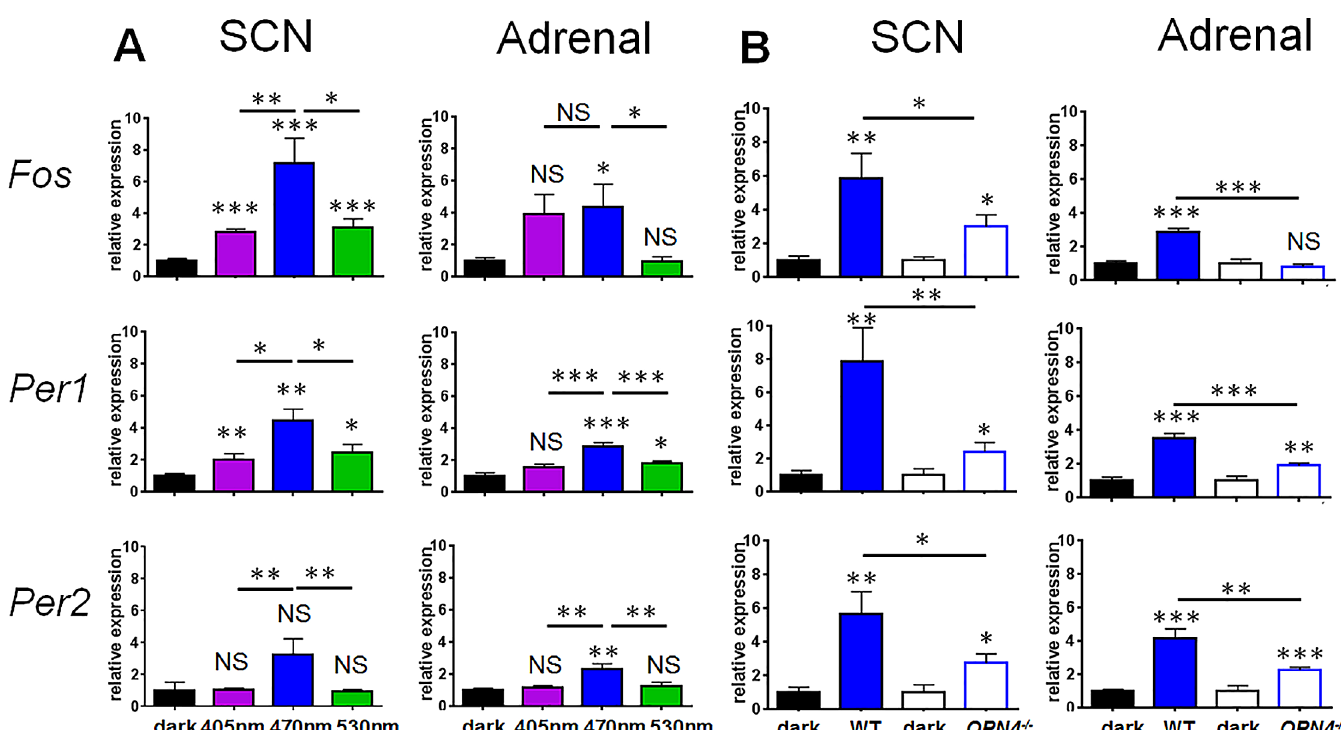
Fig 4. Wavelength-dependent effects on immediate early gene expression in the SCN and adrenal gland. ( A ) Relative mRNA expression of Fos , p (cid:1) 0.001), Per1 , and Per2 after 1 hr monochromatic light pulse in the SCN and adrenal gland. One-way ANOVA for wavelength, Fos (F (3.18) = 23.615 posthoc Tukey dark versus violet p (cid:1) 0.001, dark versus blue p (cid:1) 0.001, dark versus green p (cid:1) 0.001; Per1 (F (3.23) = 10.366, p (cid:1) 0.001) dark versus violet p = 0.006) dark versus violet p = 0.196, dark versus blue p = 0.036, dark versus blue p (cid:1) 0.001, dark versus green p = 0.007); Per2 (F (3.19) = 5.715 p (cid:1) 0.001, dark versus green p = 0.265). A significant effect of wavelength was observed in the SCN for all three genes (one-way ANOVA for wavelength, p = 0.004; Per1 F p = 0.021; Per2 F p = 0.004), with blue light showing significantly greater Fos , Per1 , and Per2 Fos F (2,14) = 8.603, (2,19) = 4.740, (2,14) = 8.565, expression in the SCN compared to either violet (posthoc Tukey Fos p = 0.006, Per1 p = 0.014, Per2 p = 0.008) or green light (posthoc Tukey Fos p = 0.012, Per1 p = 0.028, Per2 p = 0.008). In the adrenal gland, responses to blue light were significantly greater than either green or violet light. Both blue and green light induced Per1 expression (one-way ANOVA for wavelength, Per1 F (3,36) = 13.070, p < 0.001; posthoc Tukey dark versus violet p = 0.098, dark versus blue p < 0.001, dark versus green p = 0.023). Blue light produced significantly greater Per1 induction compared to either green or violet light (green versus blue p = 0.001, violet versus blue p < 0.001). Fos and Per2 expression were also induced by blue light but not violet or green light (one way ANOVA for wavelength Fos F (3.31) = 2.516 p = 0.076, dark versus blue p = 0.045; Per2 F (3.31) = 7.033 p = 0.001, dark versus blue p = 0.004). Neither violet nor green light produced a significant induction of Fos or Per2 expression ( Fos dark versus violet p = 0.063, dark versus green p = 0.979, Per2 dark versus violet p = 0.961, dark versus green p = 0.998). ( B ) Responses to blue light were subsequently studied in Opn4 -/- mice (open bars) compared with wildtype mice (solid bars). Opn4 -/- mice showed light induced gene expression for all three genes in the SCN, but responses were significantly attenuated in comparison to wildtype animals (unpaired t test wildtype versus Opn4 -/- Fos p = 0.029, Per1 p = 0.007, Per2 p = 0.029). In the adrenal gland Per1 and Per2 (but not Fos ) were induced in response to light. All three genes showed attenuated responses in comparison to wildtype mice (unpaired t test wildtype versus Opn4 -/- Fos p < 0.001, Per1 p < 0.001, Per2 p = 0.002). The geometric mean of three housekeeping genes Actb , Gapdh , and Arbp were used for normalisation. Statistically significant changes in gene expression versus control (dark) conditions are shown by symbols directly above histogram bars, whereas comparisons between wavelengths are indicated by horizontal lines. Data plotted as mean ± SEM. N = 5 – 12/group. Significant differences indicated by *** p (cid:1) 0.001, ** p (cid:1) 0.01, * p (cid:1) 0.05, NS = not significant. The data used to make this figure can be found in S4